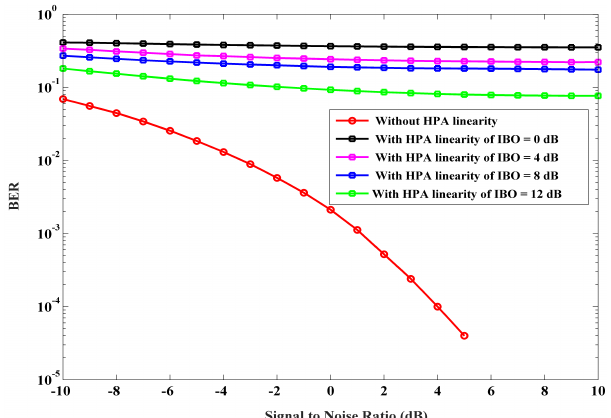
Figure 22. BER performance of the considered system with and without implementation of IBO-based HPA for the case of user 4.